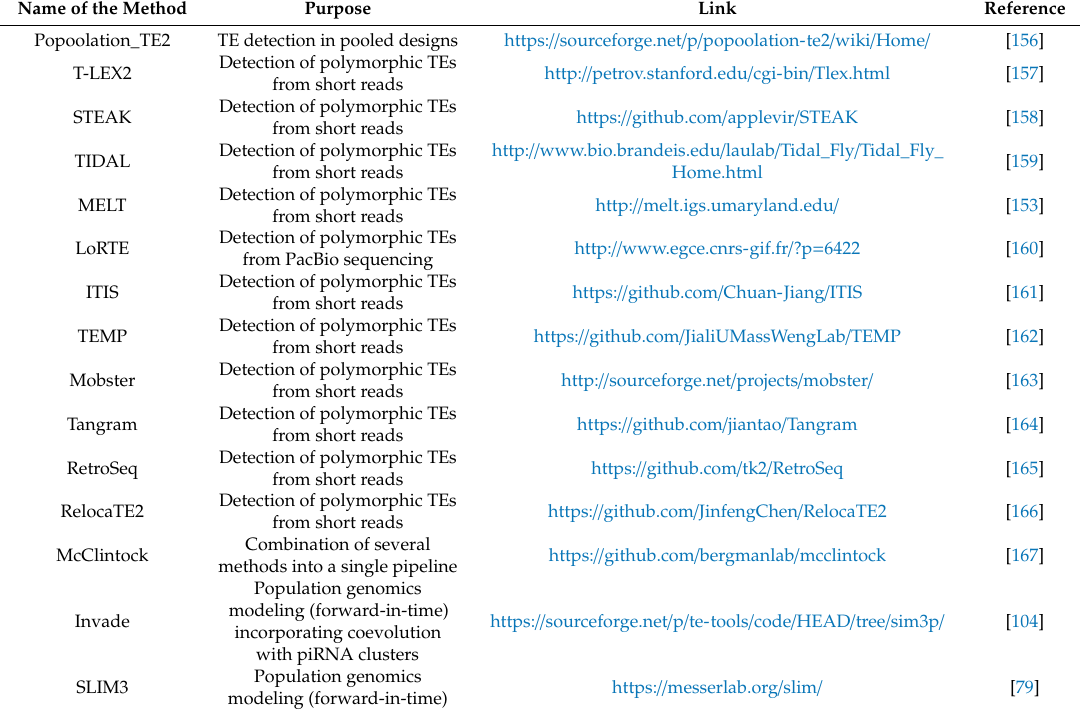
Table 1. Summary of tools commonly used for transposable elements (TE) detection and analysis. Methods that have been compared on human datasets in [155] are highlighted in